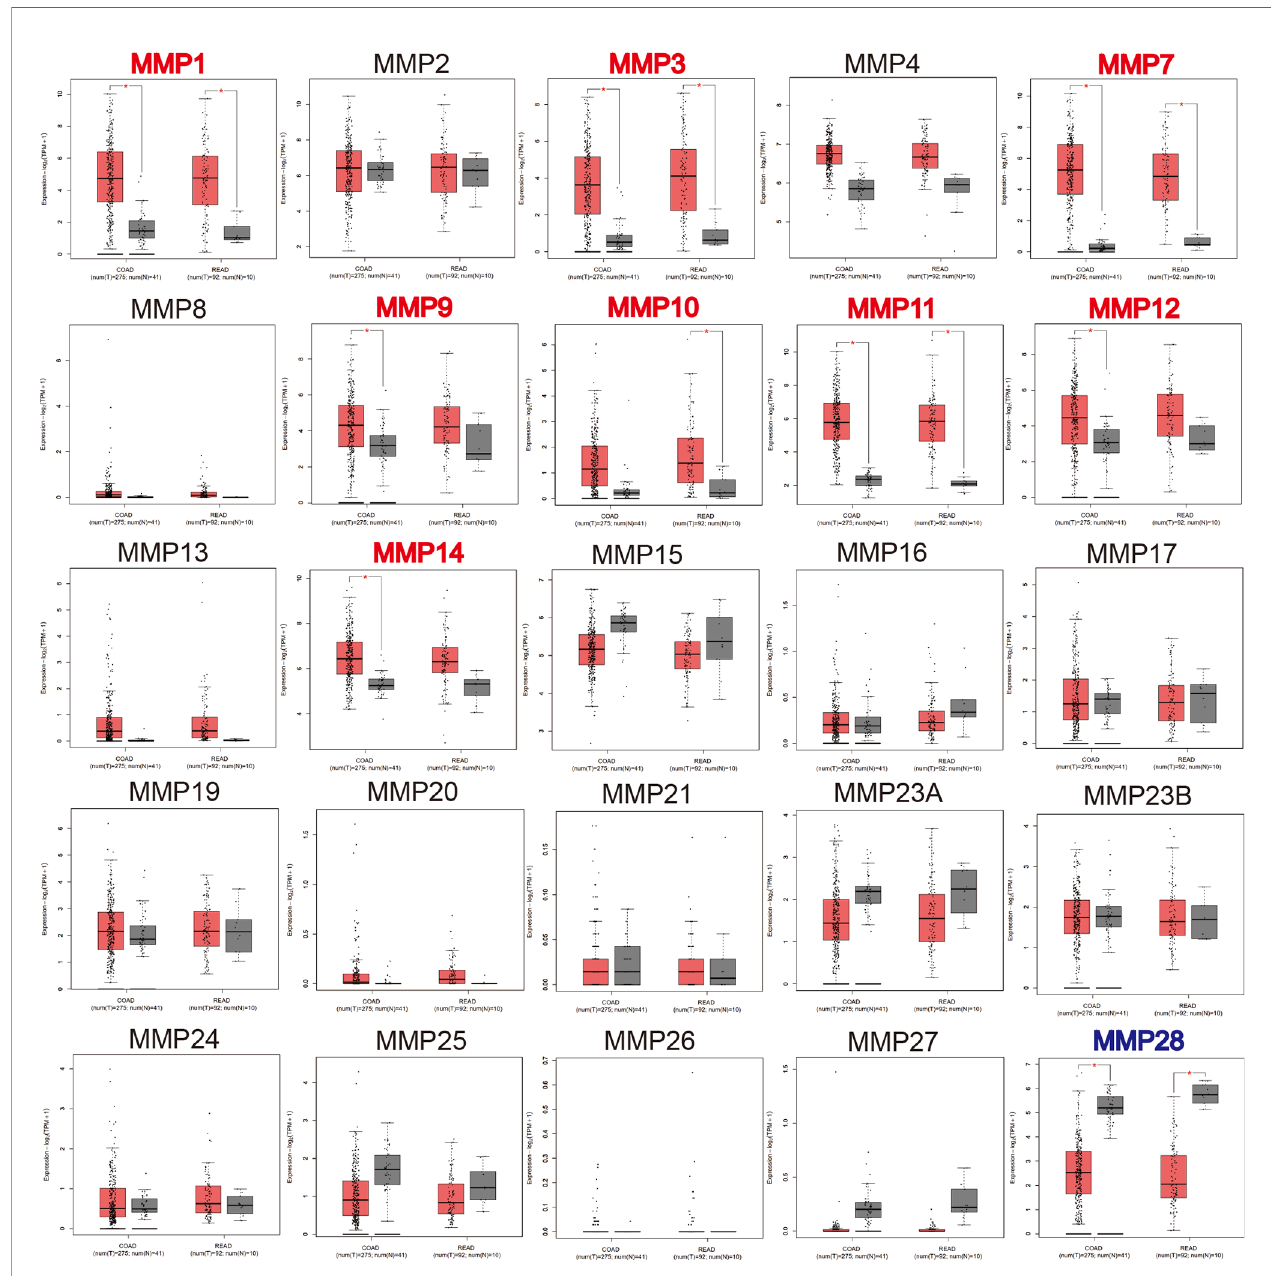
FIGURE 2 | The transcription levels of MMPs in colorectal cancer tissue and normal tissue (GEPIA). Signi fi cant records are denoted by the red asterisk on top of the boxplot. The titles of upregulated records are highlighted in red, while the titles of downregulated records are highlighted in